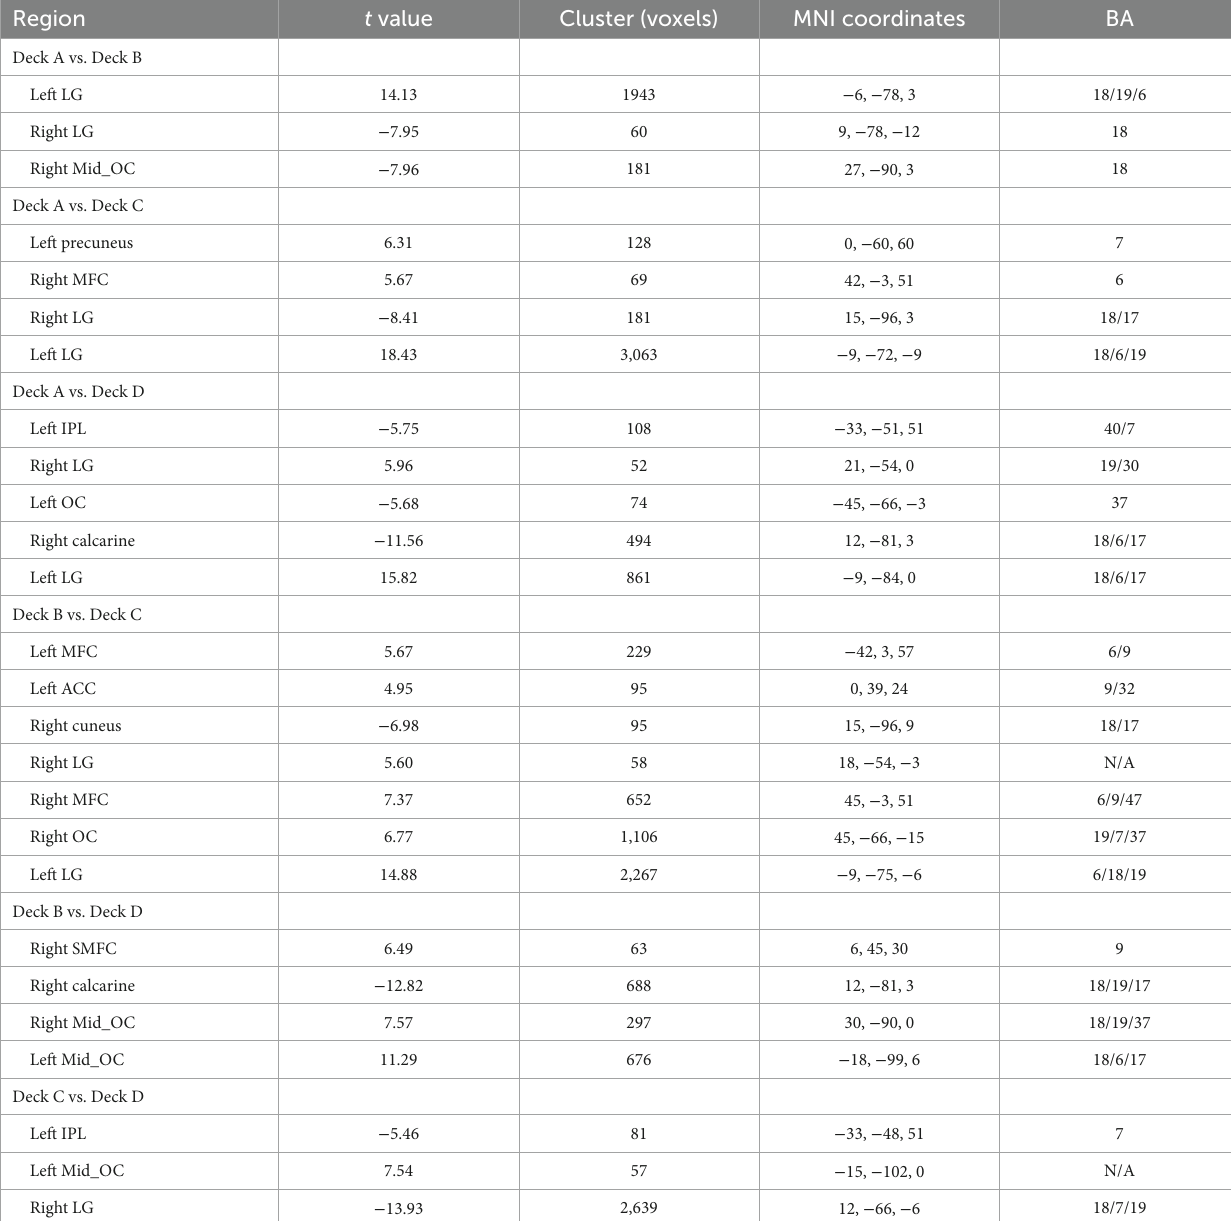
TABLE 3 The differences of brain activity between each pair of decks. Region t value Cluster